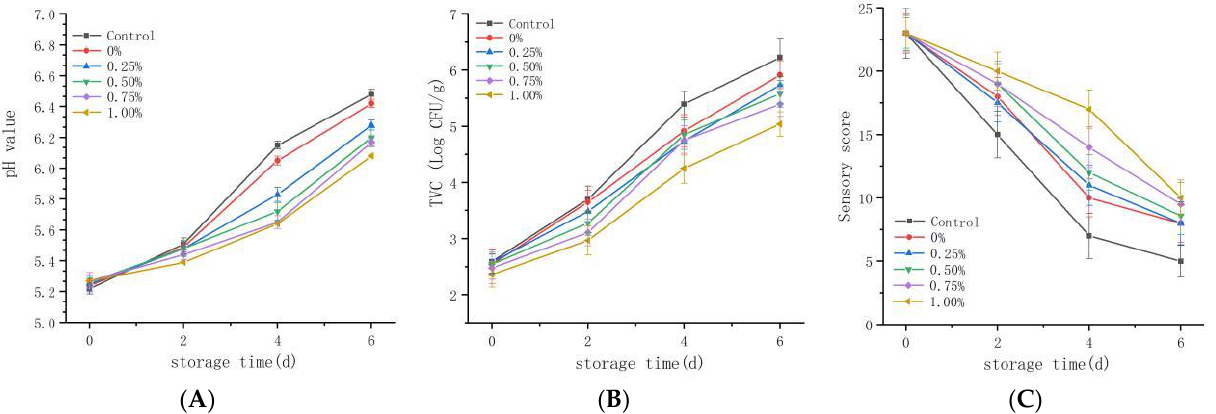
Figure 7. The pH values ( A ), TVC ( B ) and sensory evaluation ( C ) of pork samples during storage at 4 °C for 6 days. Notes: 0%, magnolol–chitosan film without magnolol. 0.25%, magnolol–chitosan film with 0.25% of magnolol. 0.50%, magnolol– chitosan film with 0.50% of magnolol. 0.75%, magnolol–chitosan film with 0.75% of magnolol. 1.00%, magnolol–chitosan film with 1.00% of